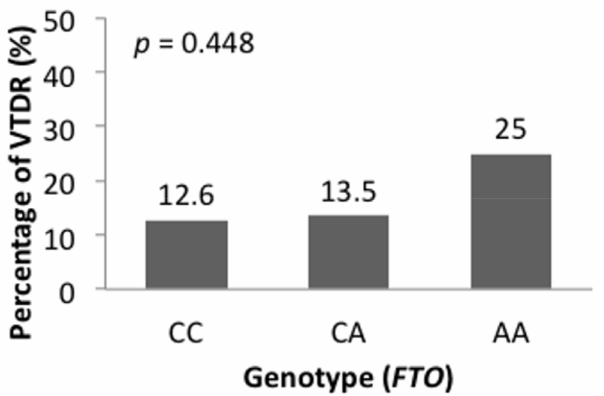
Figure 3. The prevalence of vision-threatening DR (including severe NDPR and PDR) in T2DM patients with genotypic variants (CC, CA, AA) of FTO rs8050136. p value from chi-square